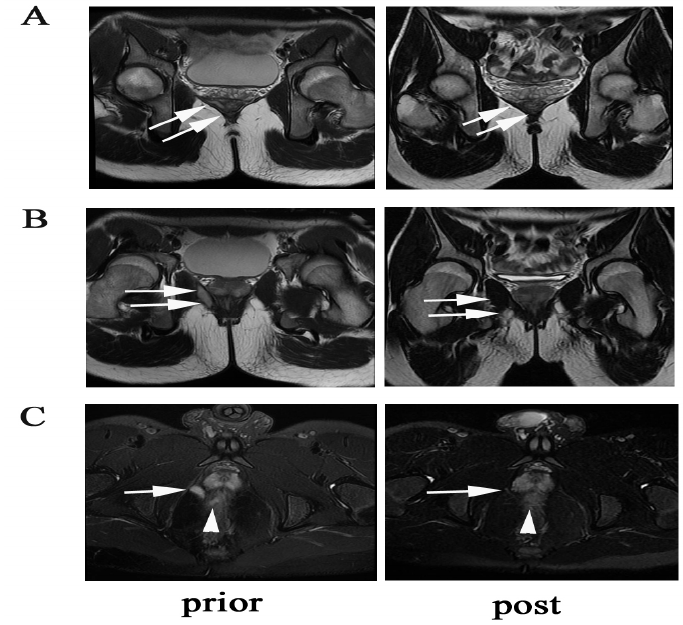
Figure 5. A case showing radiological fistula healing of a supralevator fistula. ( A ) The arrows show the supralevator part of the fistula closure with scarring. ( B ) The arrows show the infralevator part of the fistulas closure with scarring. ( C ) The arrows show vanishment of the supralevator lesion, and the triangle shows improvement of proctitis.